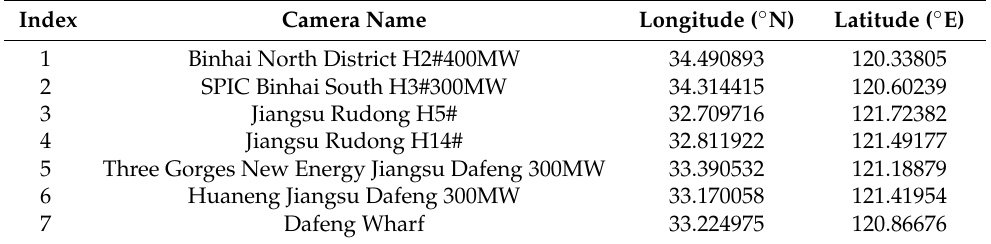
Table 1. Camera position for surveillance adopted in the East China Sea for our